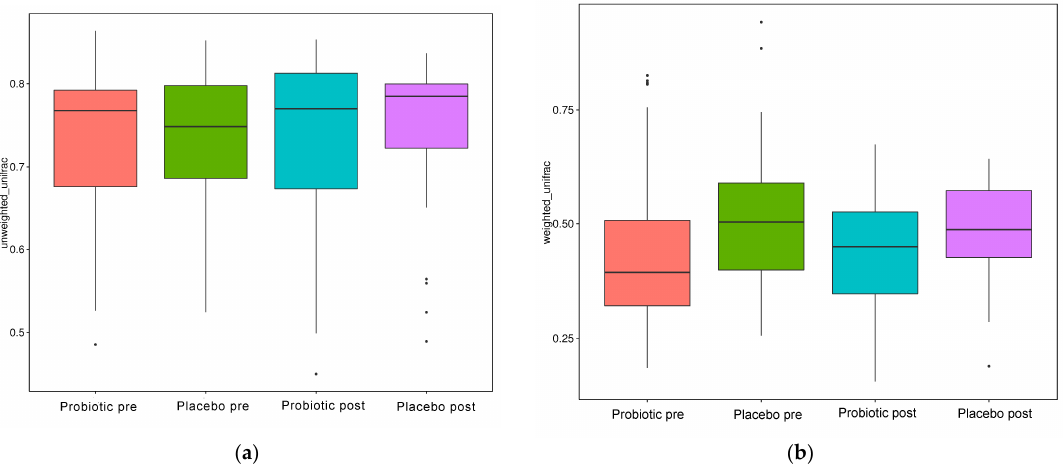
Figure 5. Beta diversity index box plot. ( a ) Unweighted and ( b ) weighted unifrac.